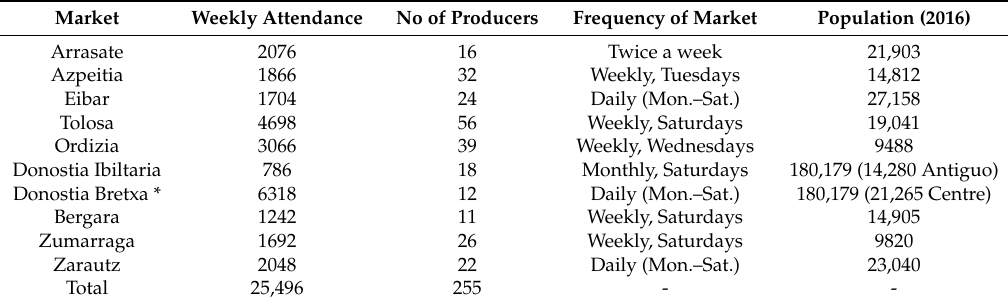
Table 1. Number of people attending markets every week and the frequency of the